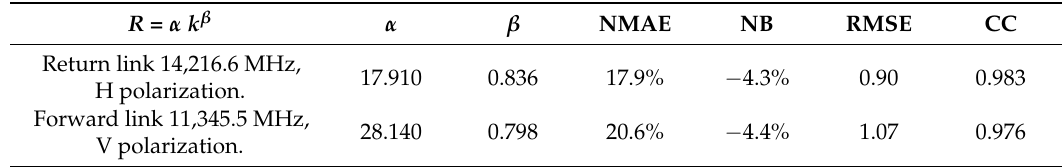
Table 2. Parameters α and β of the R-k algorithms and statistics indices between measured and estimated rain rates, in the